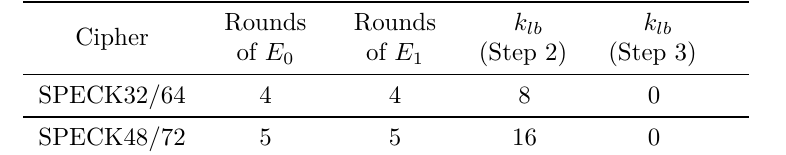
Table 3: Parameters for SPECK.